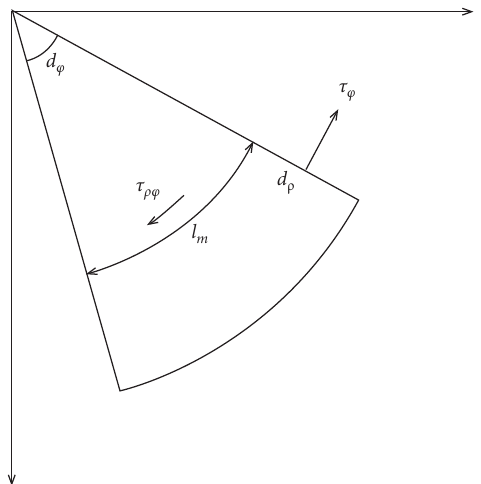
Figure 3: Elastic mechanics analysis of concrete differentials. d ρ —distance between two cylinders of a thick-walled cylinder; d φ —angle cut between two radial planes; σ stress; τ —shear stress of the ρφ